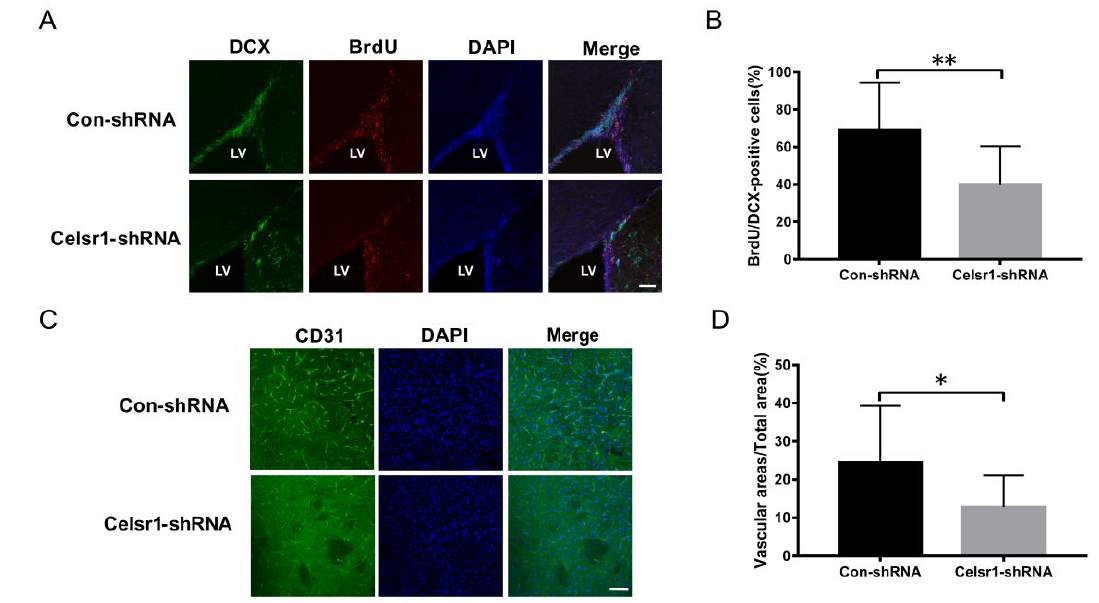
Figure 4. Celsr1 knockdown in the SVZ reduced neurogenesis and angiogenesis. ( A ) Celsr1 knockdown in the SVZ significantly reduced the number of BrdU/DCX-positive cells. Scale bar = 45 μm. ( B ) Quantitative analysis of BrdU/DCX-positive cells in the SVZ (Con-shRNA group, n = 5; Celsr1 -shRNA group, n = 4). ** p < 0.01. ( C ) CD31 staining (green) in the ischemic penumbra. DAPI (blue) was used to label the nuclei. Scale bar = 45 μm. ( D ) Quantitative analysis of CD31-positive cells upon Celsr1 knockdown in the SVZ (Con-shRNA group, n = 5; Celsr1 -shRNA group, n = 5). * p < 0.05.